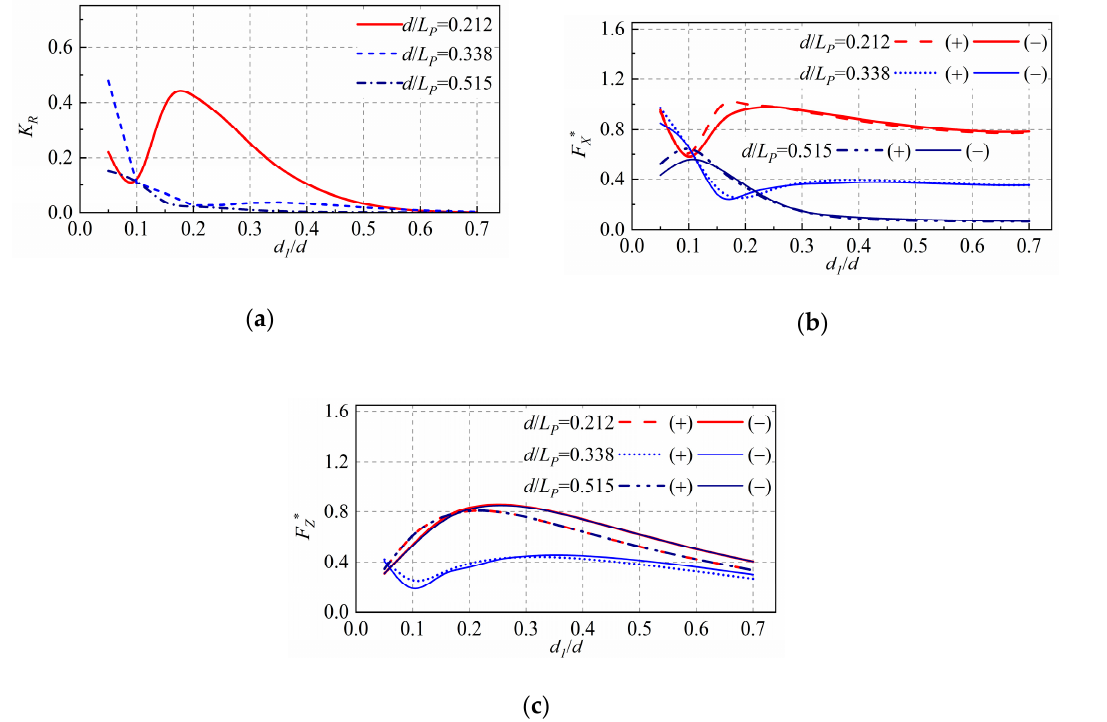
Figure 8. Variations of reflection coe ffi cients and wave forces about dimensionless submergence d 1 / d with di ff erent peak wave length ( a ) reflection coe ffi cient, ( b ) horizontal force and ( c ) vertical force.